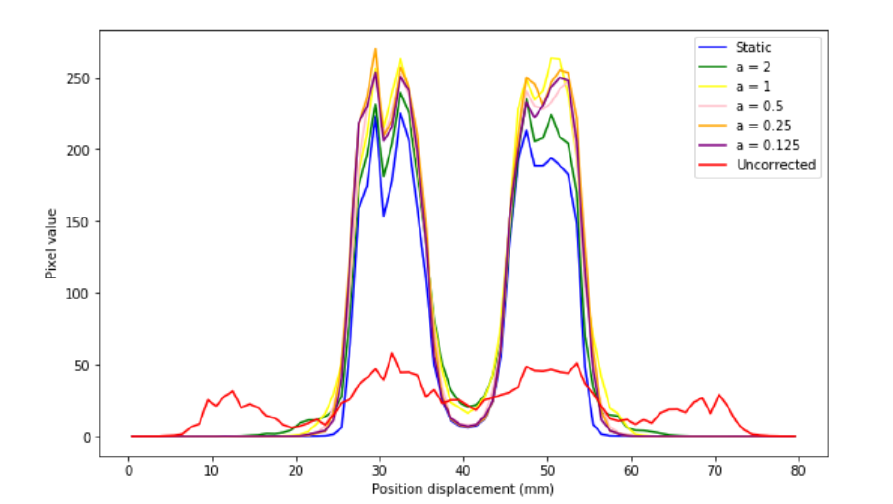
Figure 11. Profiles of the static, uncorrected image and the corresponding corrected images for the different voxel sizes of a = 0.125, a = 0.25, a = 0.5, a = 1, and a = 2.